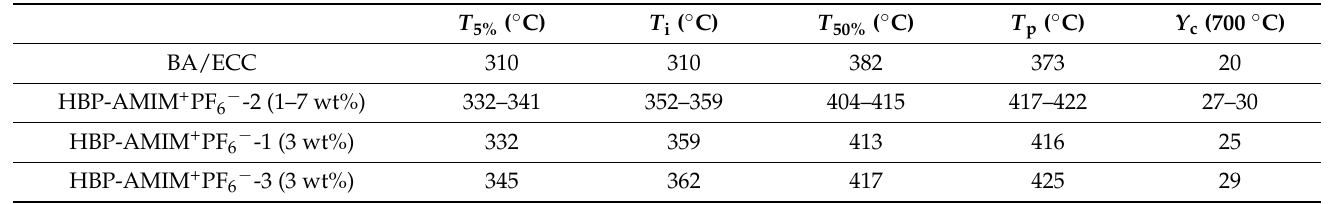
Table 4. Thermal stability and degradation data from thermogravimetric analysis under nitrogen atmosphere [352].